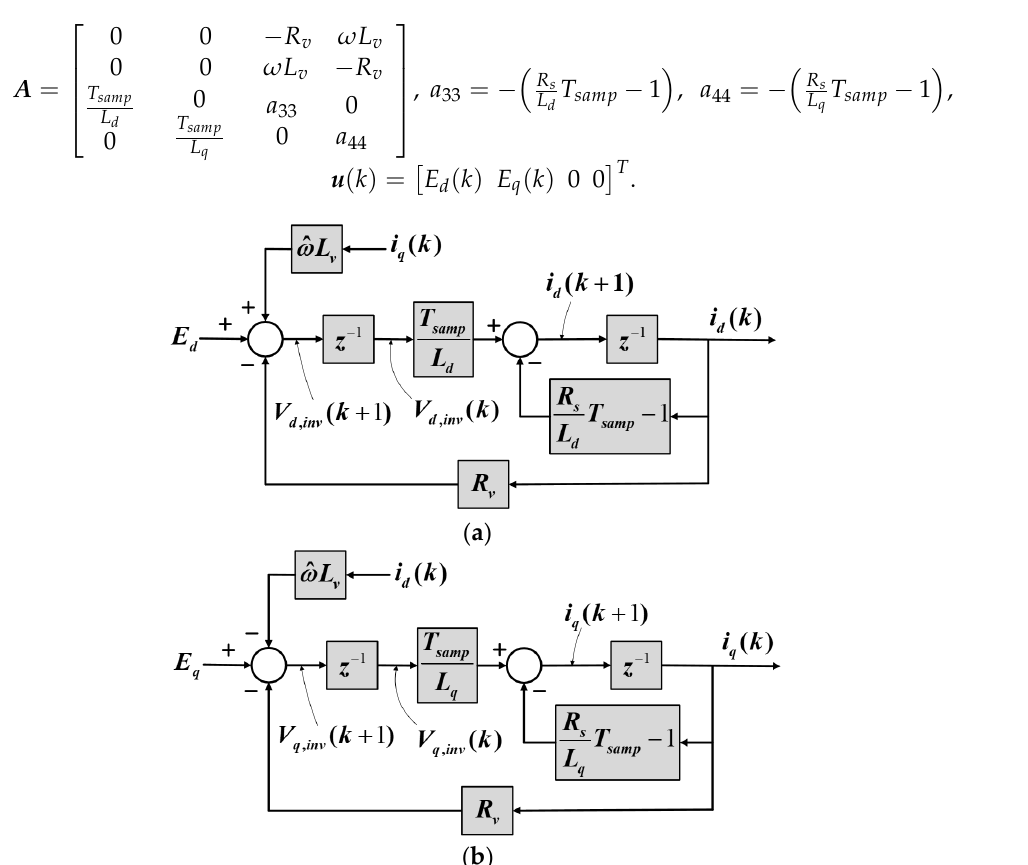
Figure 7. The d , q axis system block diagrams of the proposed flying start based on the discrete inverter model. ( a ) The d- axis model and ( b ) the q- axis model.